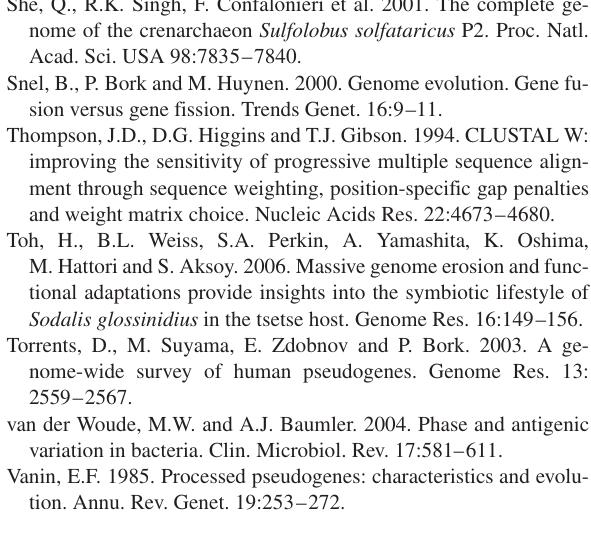
Supplementary Table S3. The GC percentages of gene sets that do and do not contain a pseudogene counterpart. Available